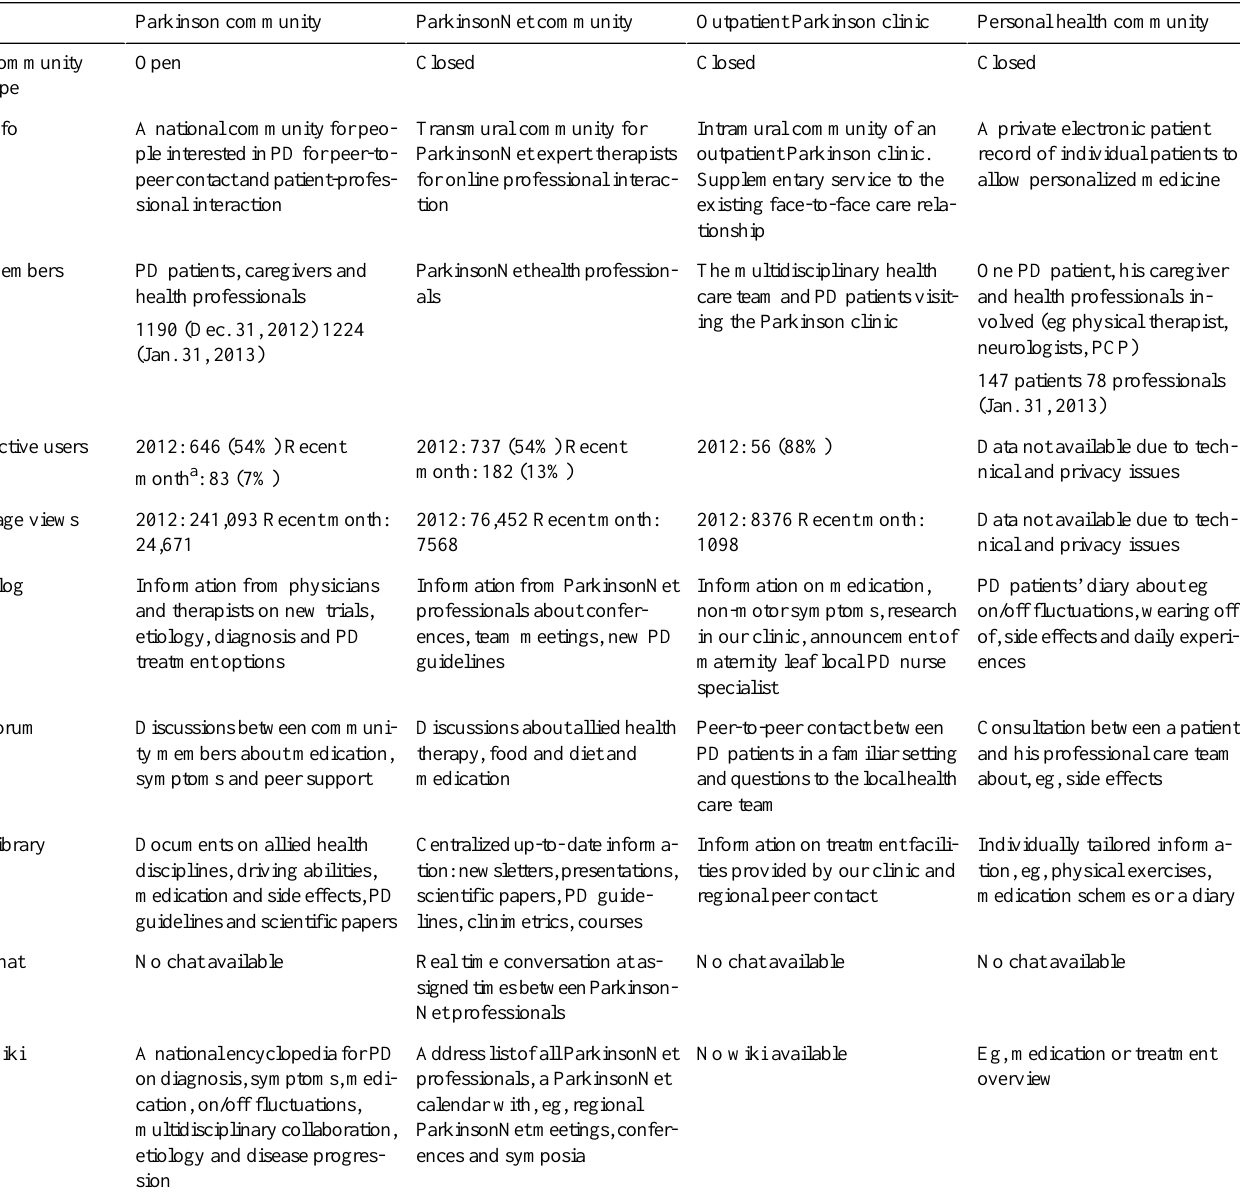
Table 1. Social media applications and members of the Parkinson